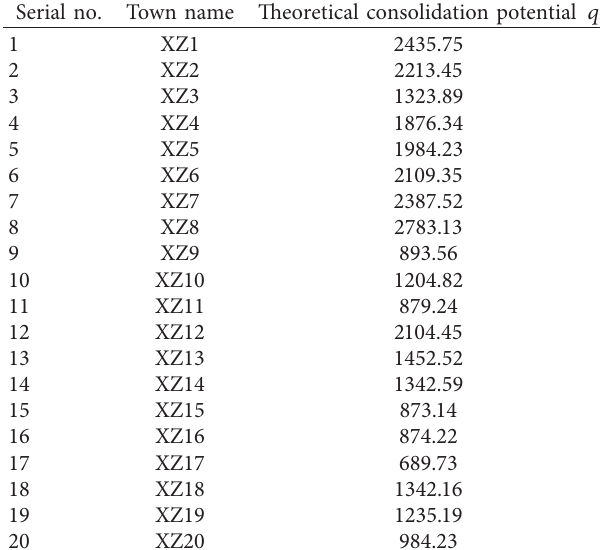
Table 5: Calculation results of the theoretical potential of 20 towns in Rugao